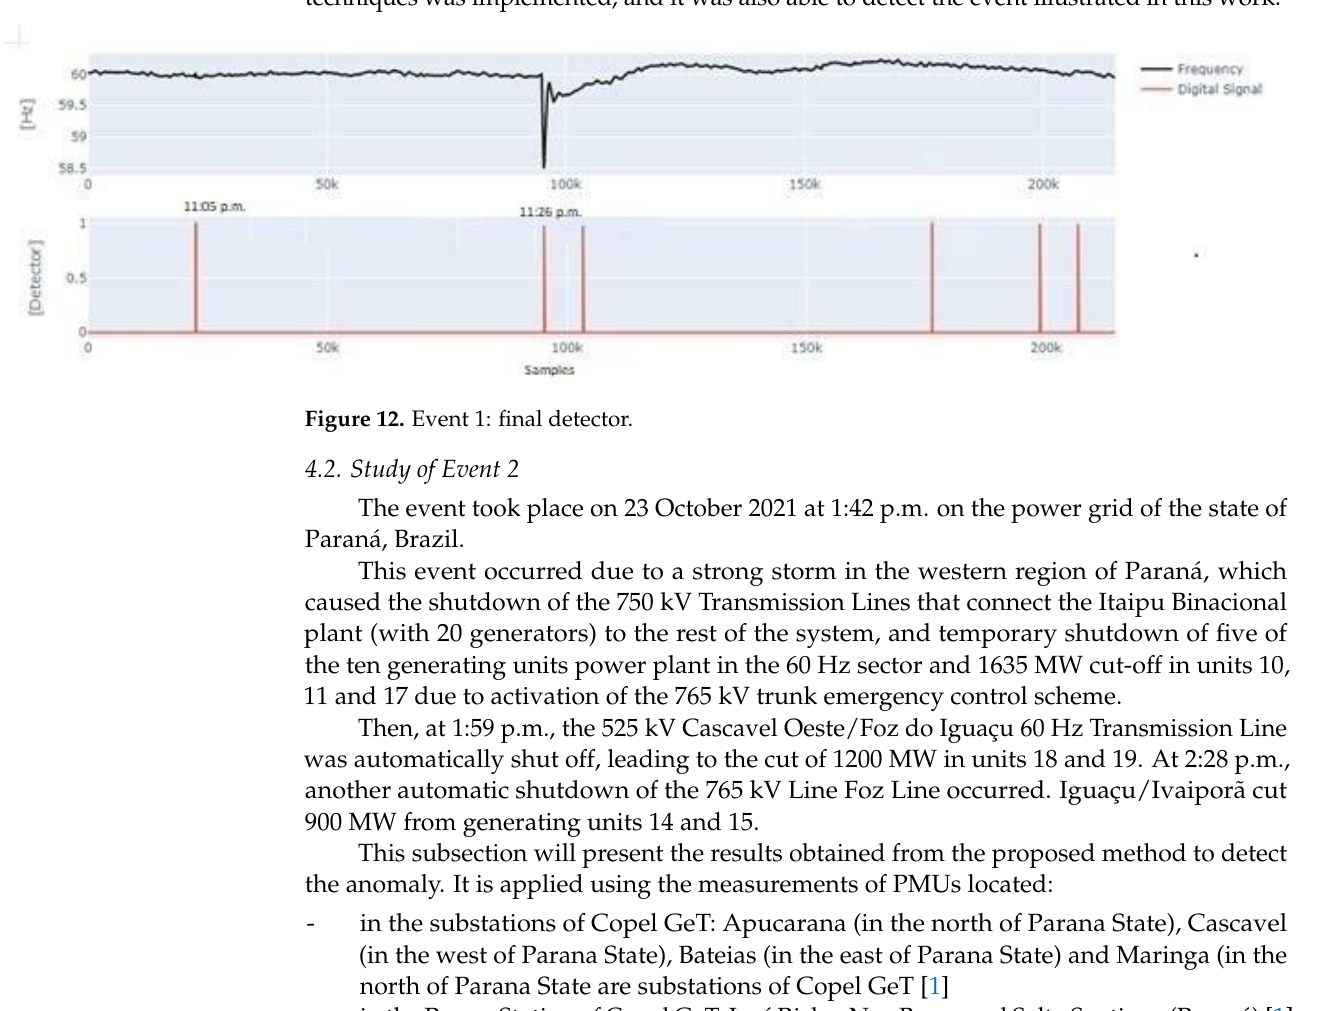
Figure 14. Event 2: detector event of PMU Cascavel (located at Parana State). Figure 15. Event 2: detector event of PMU Bateias (located at Parana State). Figure 16. Event 2: detector event of PMU Maringa (located at Parana State).